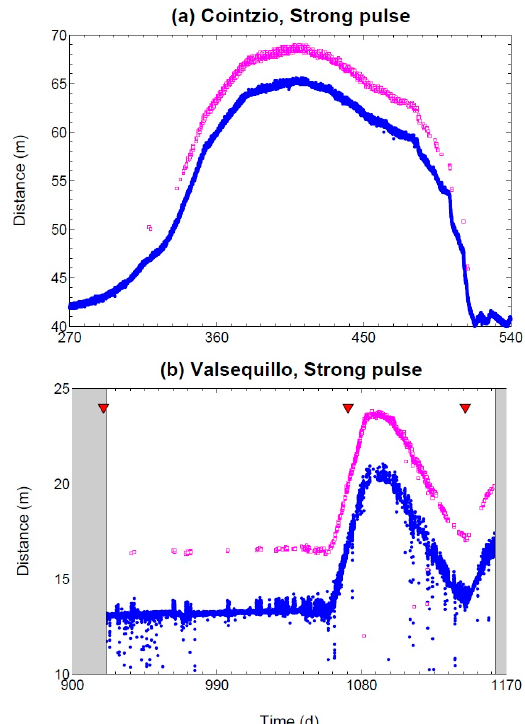
Figure A1. ( a , b ) Raw distance data measured by the test Lidar, which are associated with a moderate ( I = 3, blue circles) or a low ( I = 2, purple squares) signal strength. Considering that the distances associated with a moderate signal strength are related to the detection of a water (sub-) surface and assuming the validity of a simple model based on the Snell-Descartes law, the distance data associated with a low signal strength would correspond to an apparent layer located at a depth of ≈ 2.1 m at Cointzio and ≈ 1.7 m at